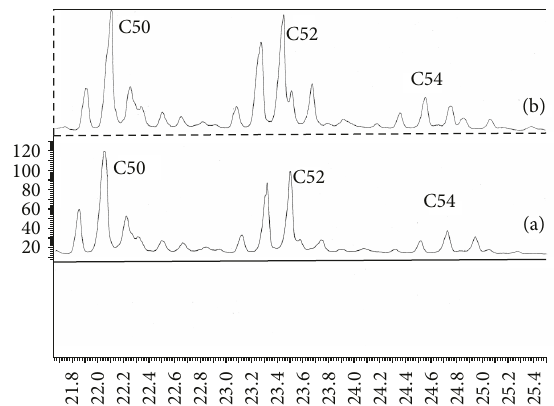
Figure 6: Details of triglyceride families with 50, 52, and 54 carbon atoms in authentic butter (a) and butter adulterated with 8% lard